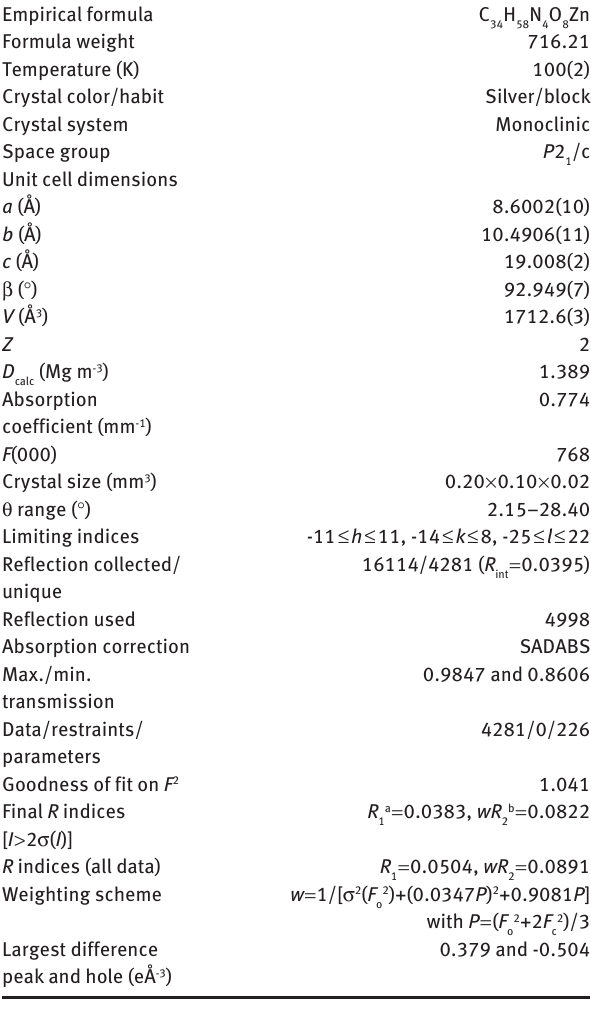
] ( 1 ). Table 3 Crystallographic data for [Zn(L)(Hcpdc) 2